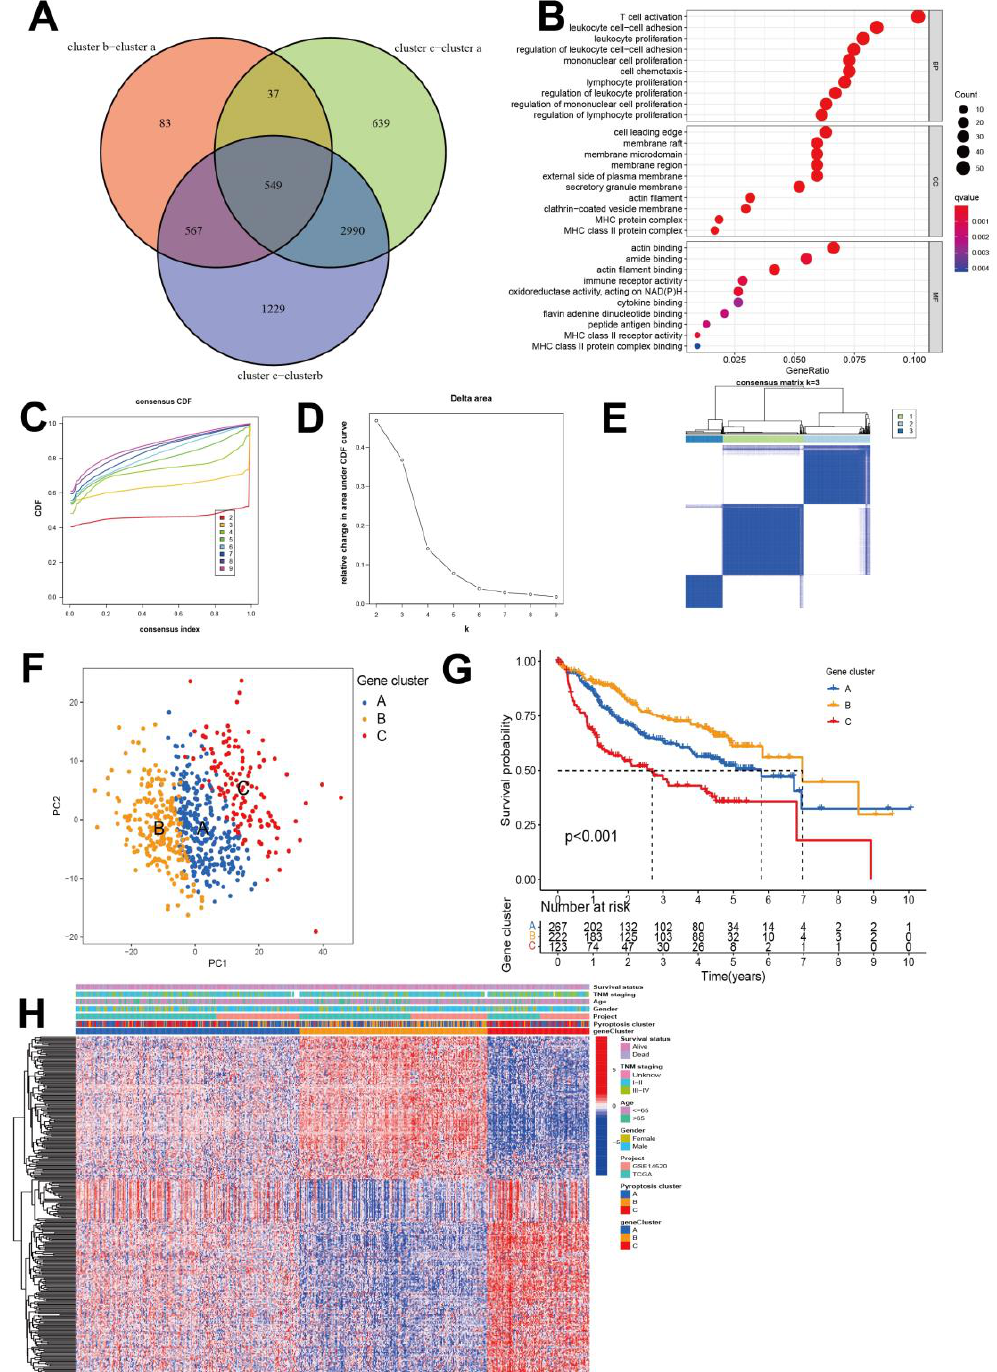
Figure 3. Identification of subtypes based on differentially expressed genes (DEGs). ( A ) Overlapping analyses of significant genes using a Venn diagram. ( B ) GO analysis of overlapping DEGs, (the distance from left y axis means gene ratio, the size means the enriched gene counts). Construction of gene clusters, an unsupervised clustering of DEGs in two cohorts’ projects to classify different genomic subtypes, termed gene clusters A – C, respectively. ( C ) Cumulative distribution function curve, ( D ) cumulative delta area under CDF of k = 1 to 9, and ( E ) Sample clustering heat map (k = 3). ( F ) PCA plot of gene clusters A (blue), B (yellow), and C (red). ( G ) Survival analysis of gene clusters A (blue), B (yellow), and C (red). ( H ) The pyroptosis clusters, gene clusters, age, gender, tumor stage, survival status, and projects were used as patient annotations.